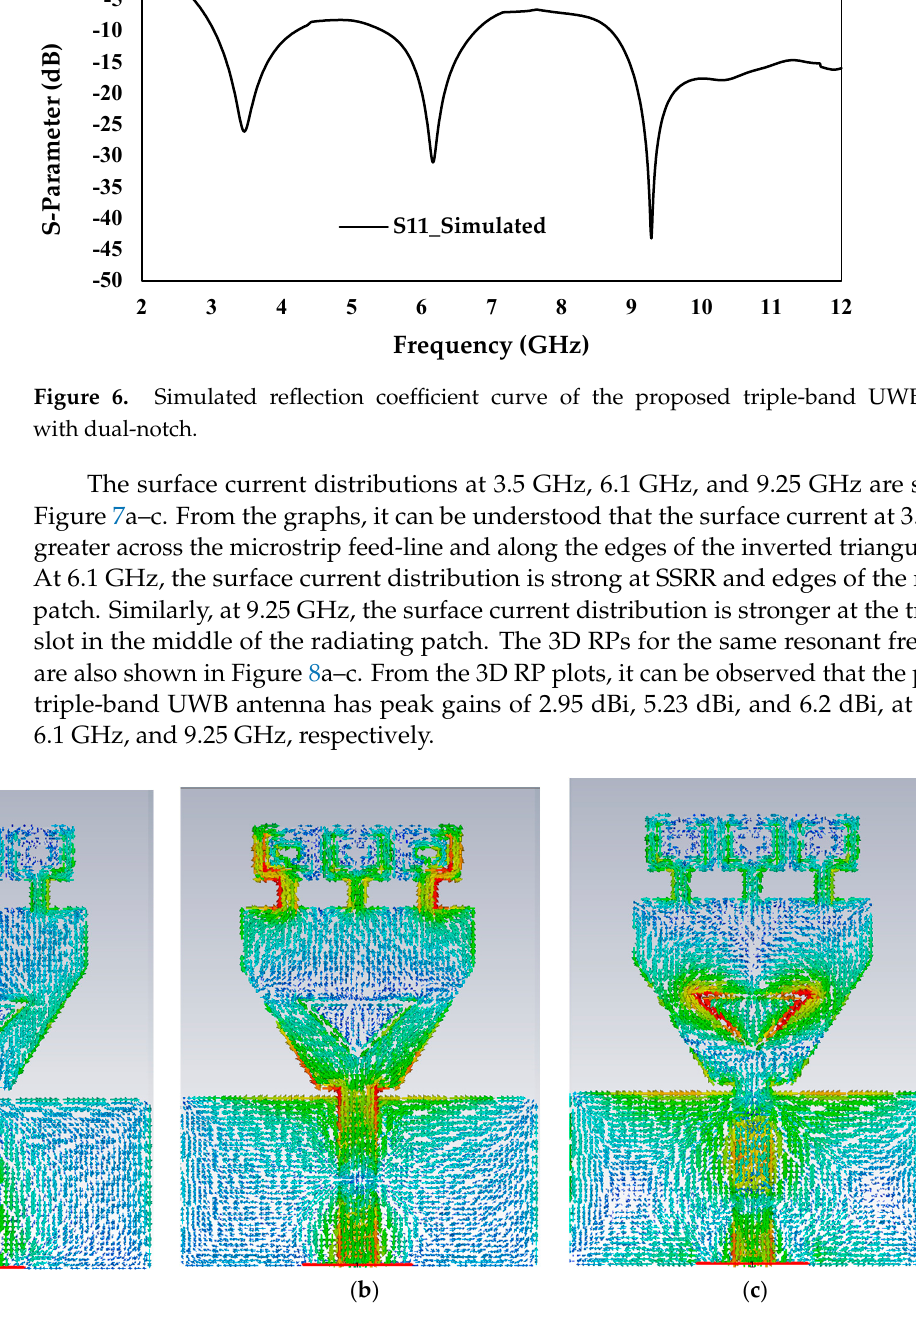
Figure 8. Simulated 3D RPs at ( a ) 3.5 GHz ( b ) 6.1 GHz ( c ) 9.25 GHz. 3. Parametric Study In the parametric analysis, a comparative study of S-parameter performance has been carried out by varying the dimensions of triangular slot width ( S ) and SSRR slot width ( t ) of the radiating patch as illustrated in Figure 9a,b. From Figure 9a, it can be understood that one of the rejection band frequencies shown in Table 2 can be shifted by varying the dimension ‘ S ’ on the main radiating patch. At S = 0.65 mm, 0.9 mm, and 1.15 mm, the corresponding higher rejection-band frequencies are tuned between 6.72–9.1 GHz, 6.77– 8.7 GHz, and 6.73–8.5 GHz, respectively, although the lower rejection-band between 4.2– 5.45 GHz remains the same in all cases. The higher operational band is also varied accord- ingly. The second analysis has been performed by varying the dimensions of parameter ‘ t ’ and it can be seen in Figure 9b, that the middle operational band was shifted. At t = 0.4